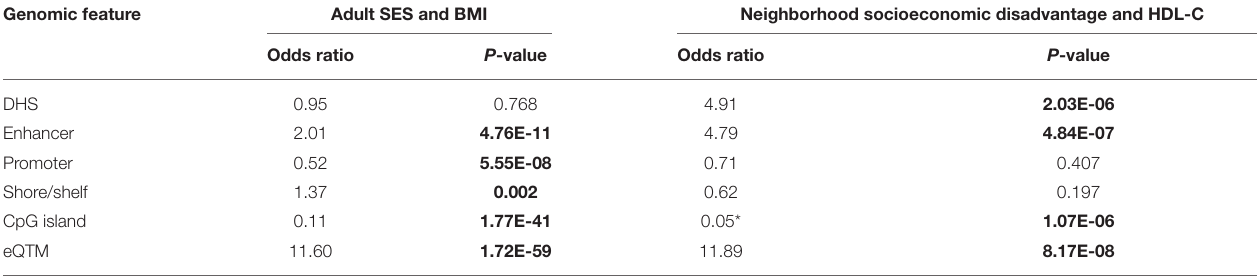
TABLE 3 | Genomic feature enrichment using two-sided Fisher’s exact